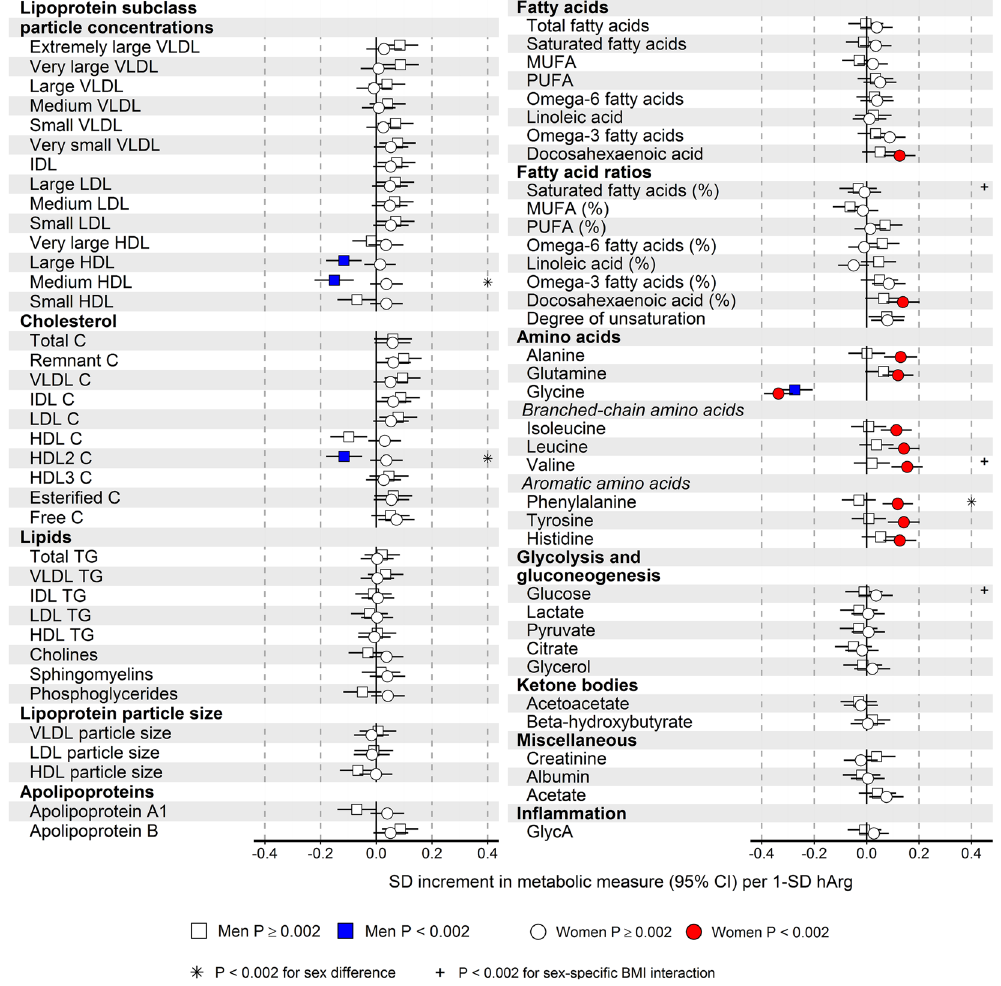
Figure 2. Sex-specific cross-sectional associations of baseline hArg with 73 NMR-based serum metabolites, adjusted for age, body mass index (BMI), daily smoking, serum SHBG and oral contraceptive use (in women). The analyses were conducted for 867 men and 1097 women. Squares indicate men, and circles represent women. Open and closed symbols indicate P ≥ 0.002 and P < 0.002, respectively. Sex differences with P < 0.002 are marked by asterisks. BMI interactions with P < 0.002 are marked by the plus or minus sign, depending on the direction of the estimated interaction